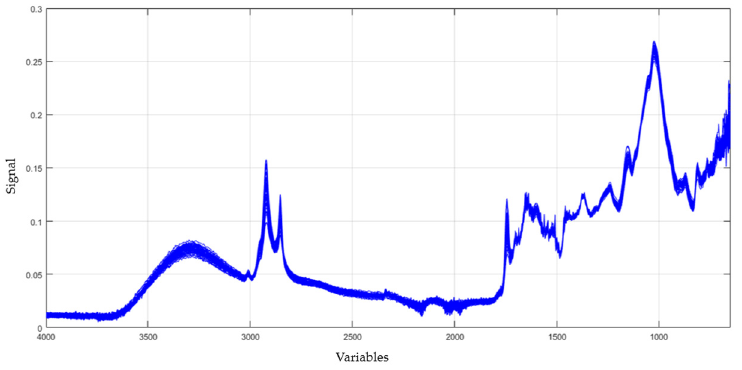
Figure 4. Multiplicative dispersion correction (MSC) of pre-treated infrared spectra of coffee samples submitted to the five fermentation times and three temperatures.